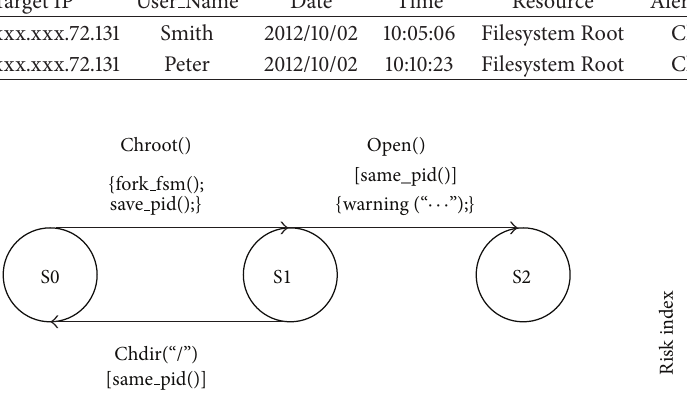
Figure 4: Escaping the chroot jail.